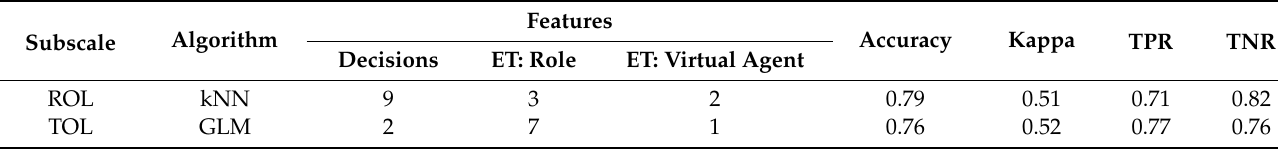
Table 6. Best model achieved for each leadership subscale and the category of features selected by them. The values shown per metric are the mean values of the 5 × 2 repeated cross-validation iterations. Subscale